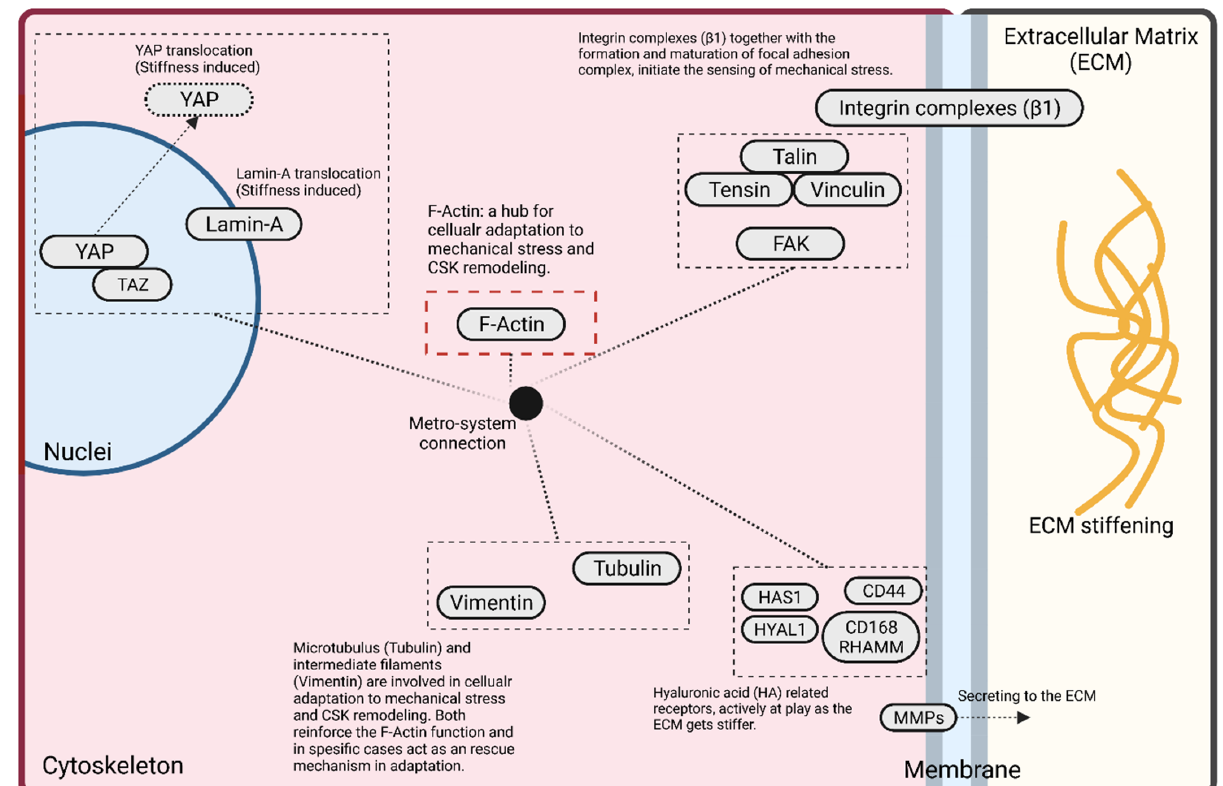
Figure 5. Mechanotransduction in GBM cells. Extracellular matrix (ECM) stiffening applies mechanical stress to GBM cells which activates focal adhesion complex formation. Focal adhesion complexes transmit the mechanical stress to cytoskeleton and initiate the CSK remodeling, where F-actin polymerization is highlighted as the hub which orchestrates a metro-system connection between several adaptive cellular signaling pathways [19,20,101,103,120–122].